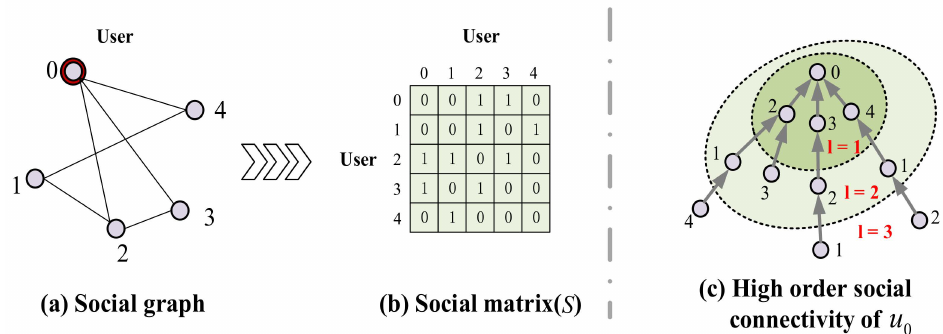
Figure 4. Social relationships. The target node u 0 is marked with a double circle in the social graph.